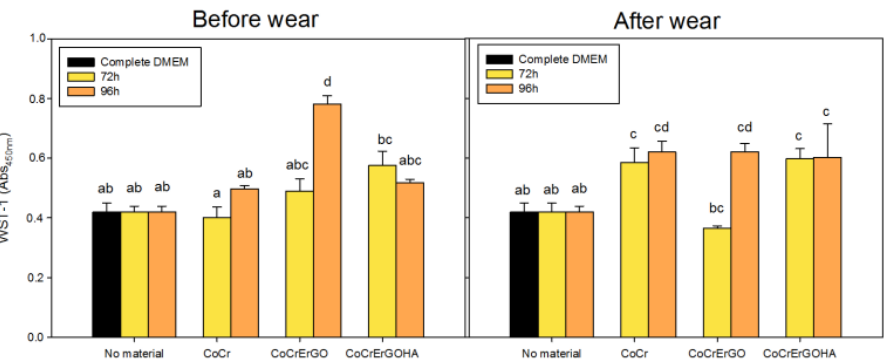
Figure 5. WST-1 assay revealed an increased response of pre-osteoblasts against the supernatant from the CoCr after the wear assay (72 and 96 h) and ErGO before the wear assay (96 h). The profile of response toward ErGOHA has not shown significant differences with CoCr. The results are expressed as (cid:101) x ± SD. Samples sharing identical letters do not have statistically significant differences with p <